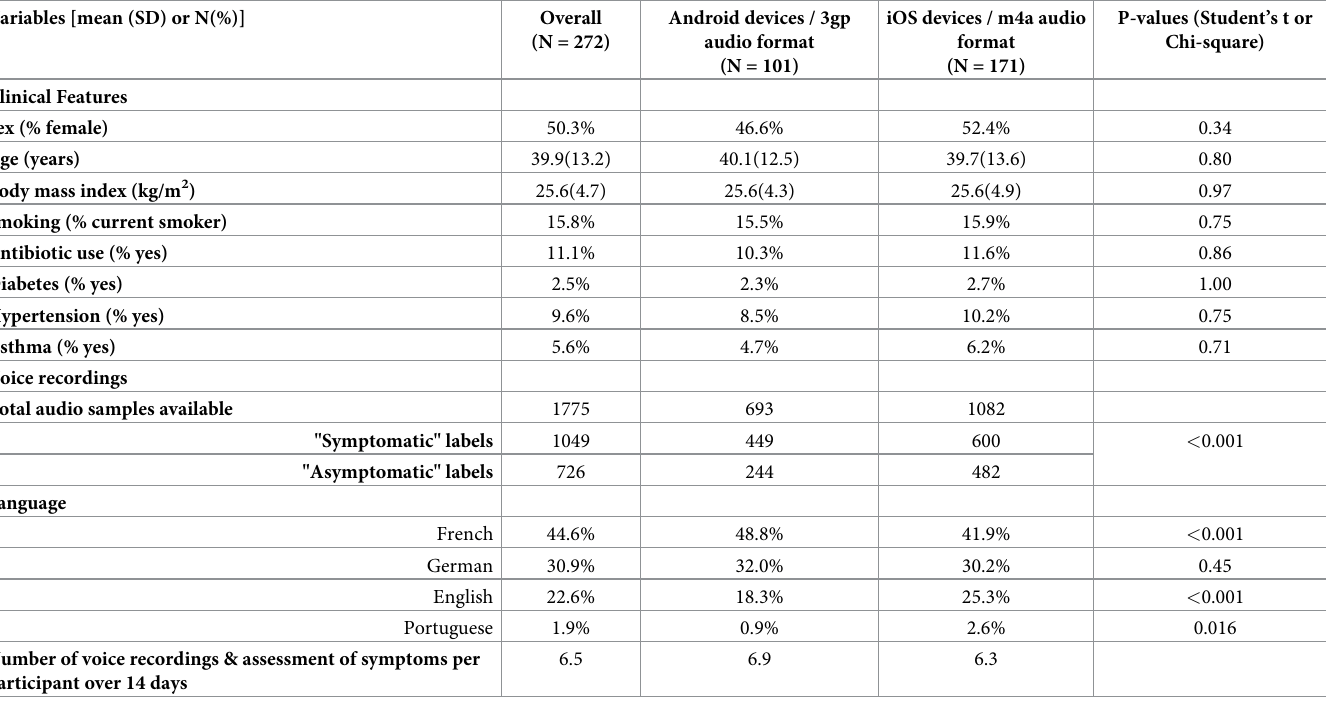
Table 2. Overall study participants’ characteristics split by type of smartphone/audio format (Predi-COVID Cohort Study, N = 272). Variables [mean (SD) or